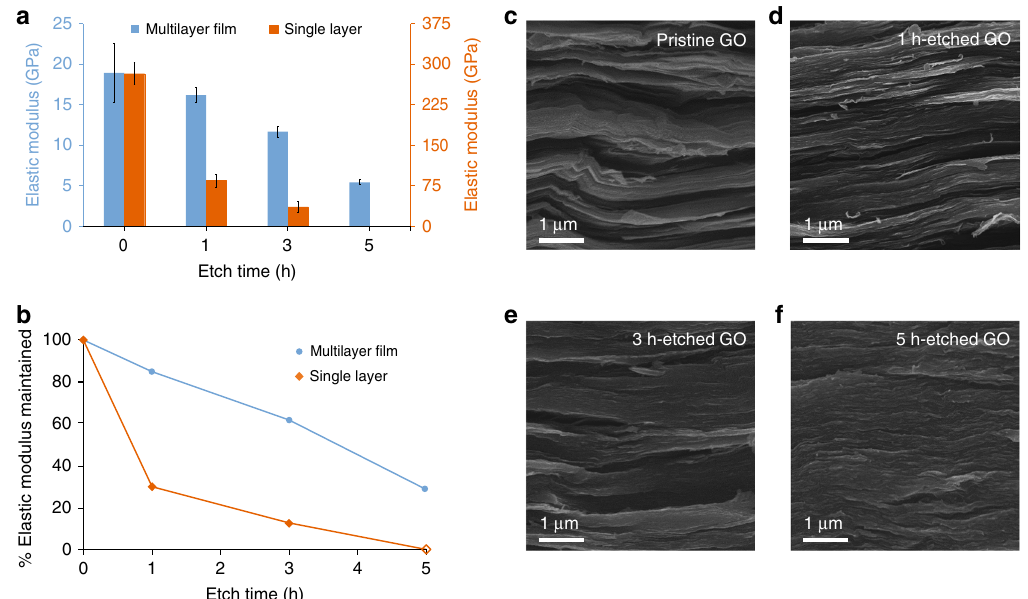
Fig. 3 Scaling of mechanical properties from single layers to multilayer fi lms. a Elastic moduli of single-layer pristine and etched GO sheets and the corresponding multilayer fi lms. Error bars represent SD. b Percentage reduction of the elastic moduli of GO sheets as etching time increases, showing that multilayer fi lms are much more tolerant to etching than single layers. SEM fractographs (i.e., images of the fracture surfaces) of multilayer fi lms of c pristine, d 1-h-etched, e 3-h-etched, and f 5-h-etched GO sheets